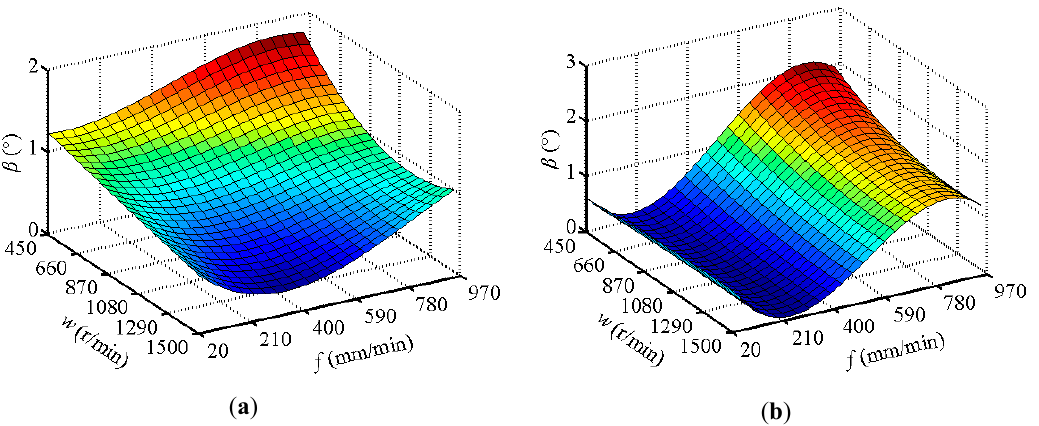
Figure 12. Surface graphs of F y max regression model: ( a ) Up-beating ( m = 1); ( b ) Down-beating ( m = –1).